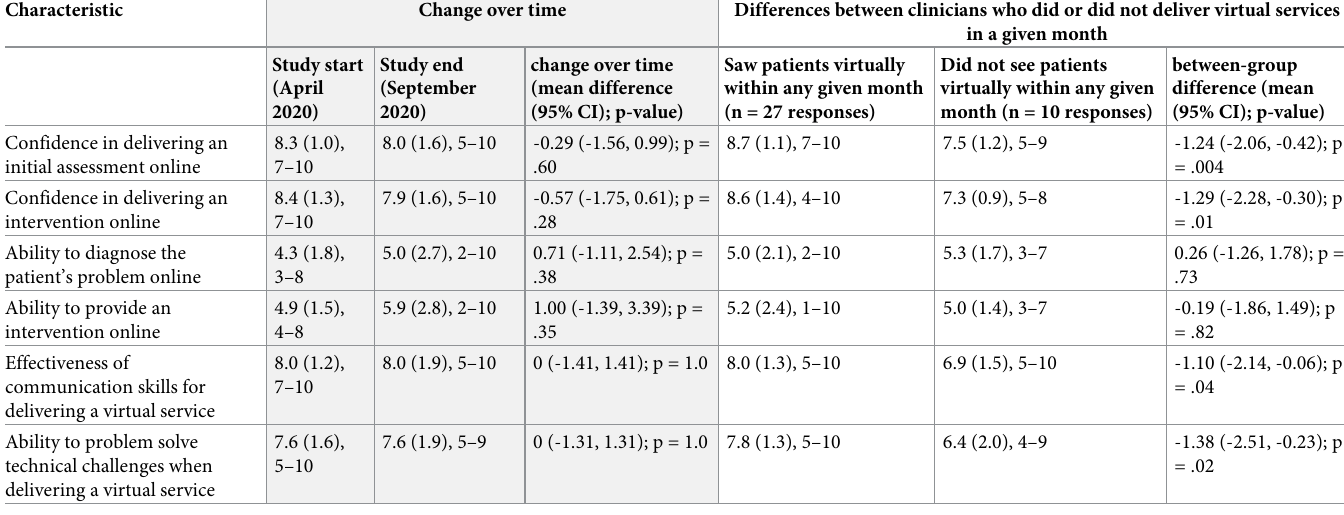
Table 3. Clinician (n = 7) confidence for delivering healthcare virtually over the study